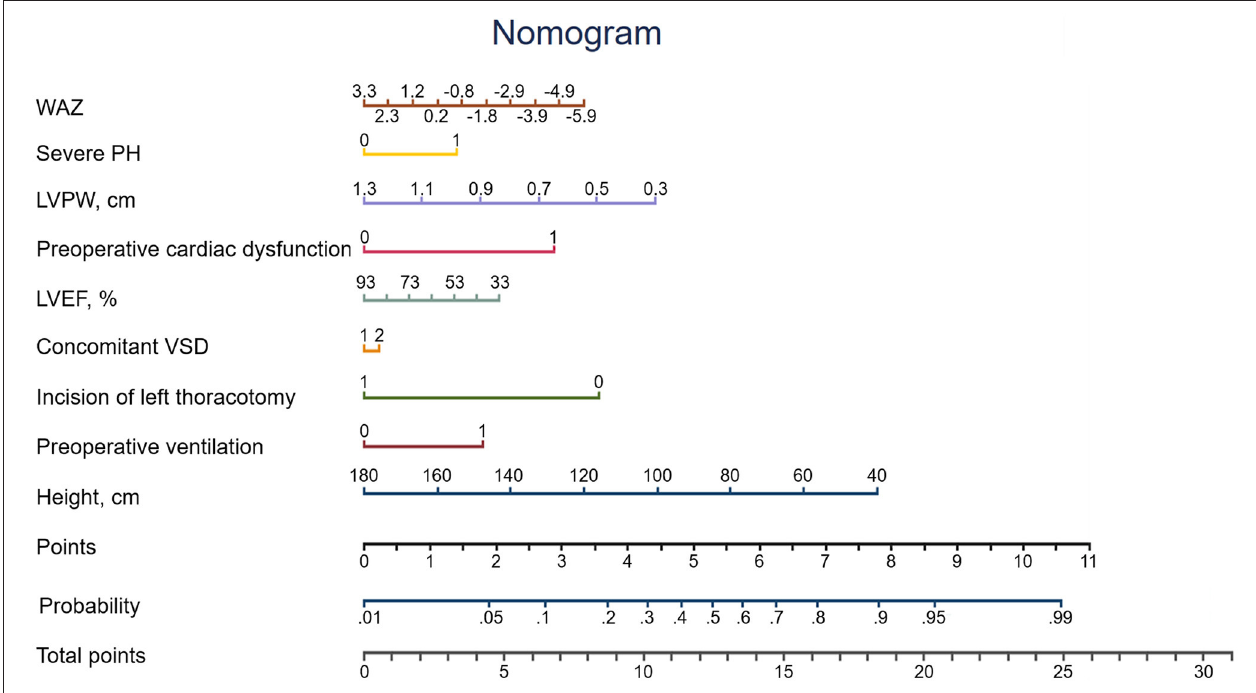
FIGURE 2 | Nomogram of the newly developed Lasso model.